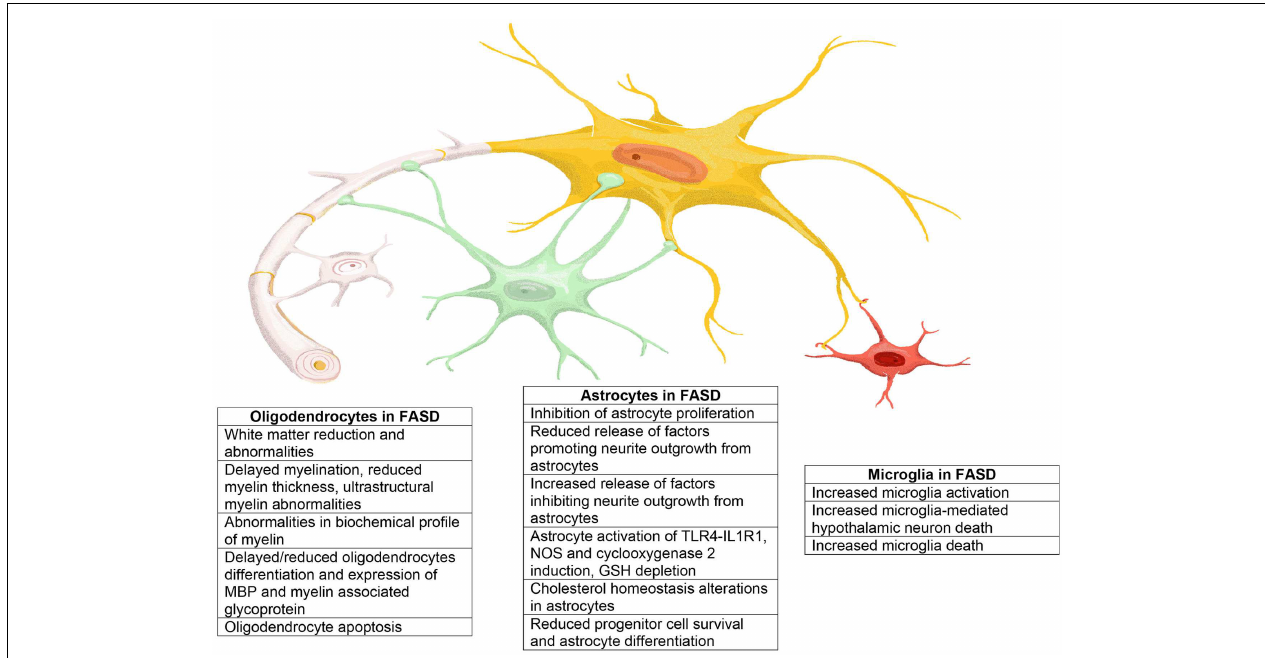
FIGURE 4 | Representation of the main effects exerted by ethanol on astrocytes, oligodendrocytes, and microglia that may play a role in the neuropathology of FASD